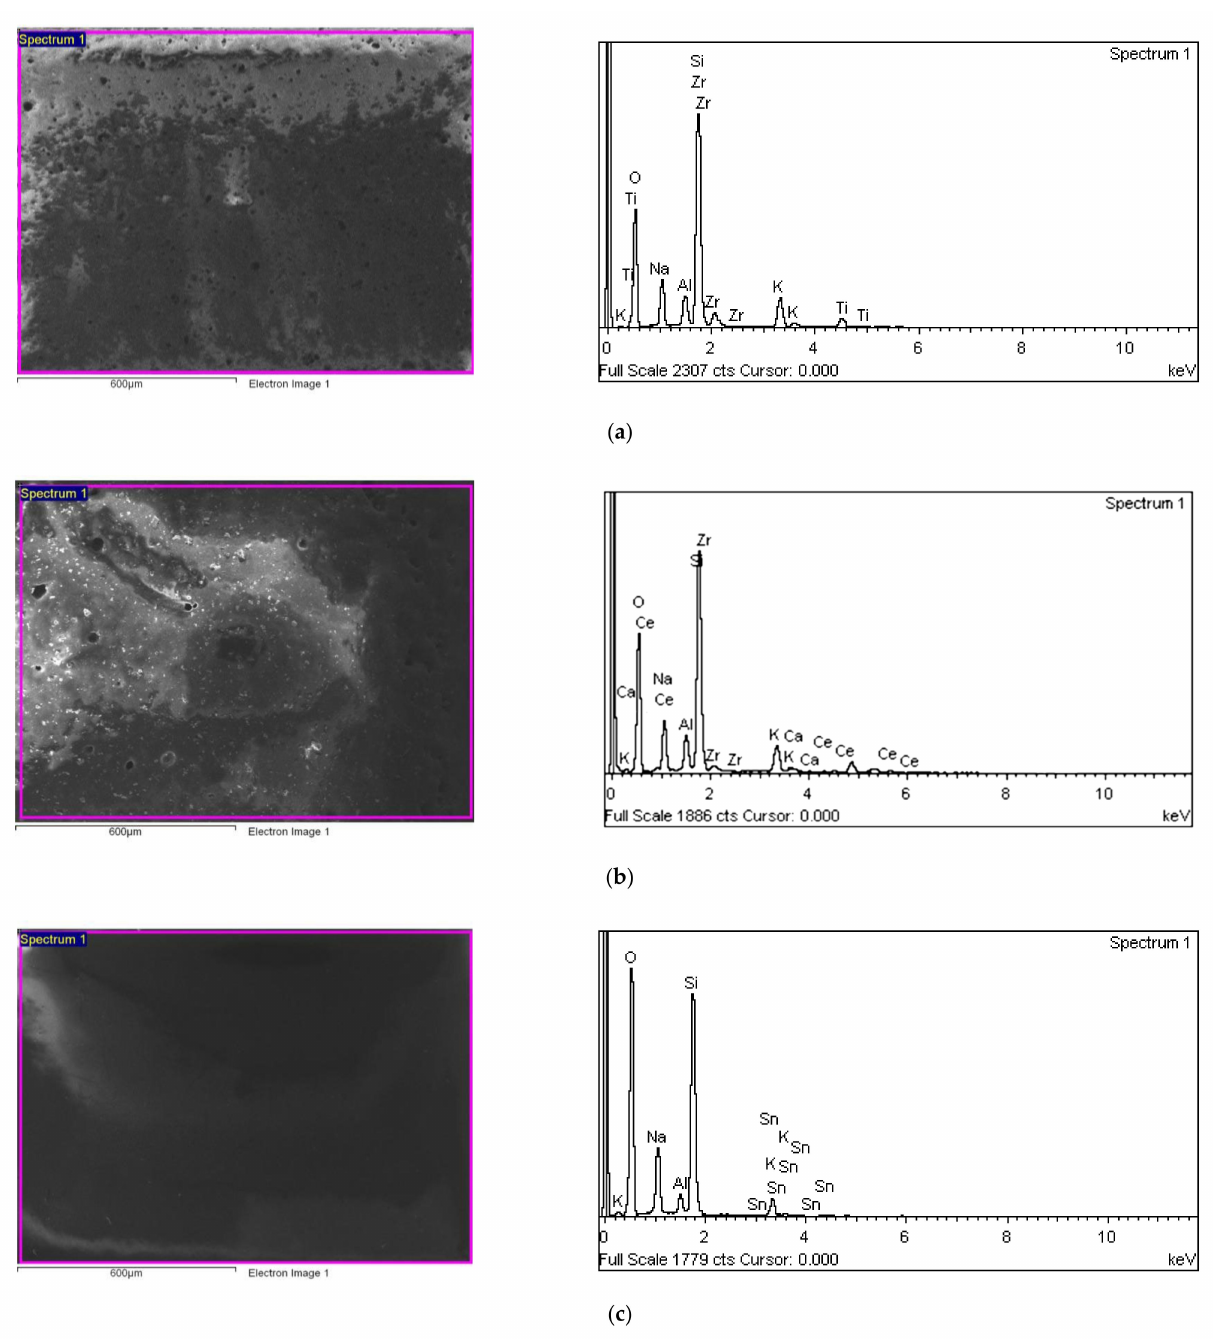
Figure 3. Microstructure and chemical analysis (SEM-EDS) of the substrates sandblasted with Al 2 O 3 (reference sample) and coated with a Duceratin porcelain layers ( a ) Bond, ( b ) Opaque, ( c )